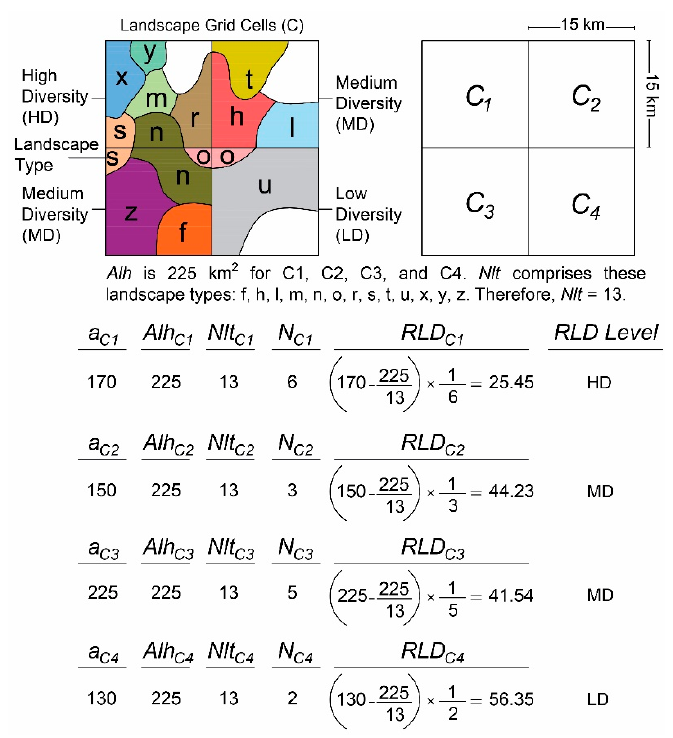
Figure 5. The computation of relative landscape diversity (RLD) for four grid cells.